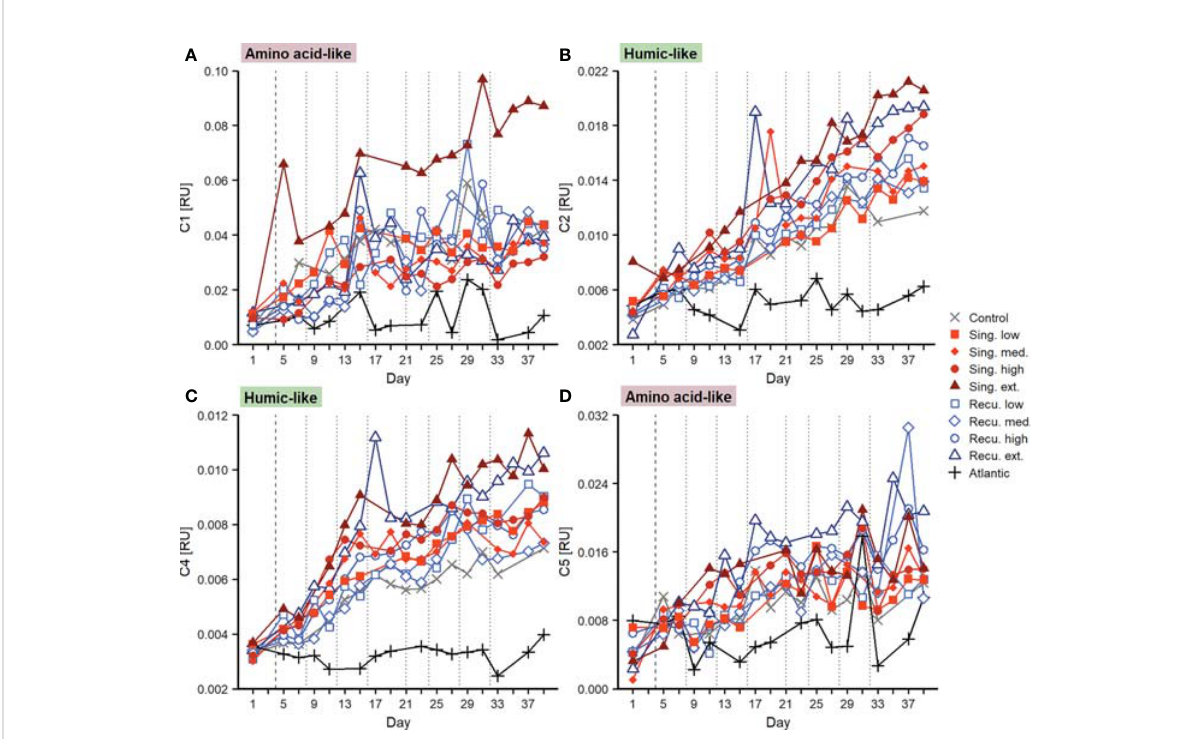
FIGURE 6 Changes in fl uorescent dissolved organic matter during the experiment. Temporal evolution of PARAFAC components (A) C1, (B) C2, (C) C4 and (D) C5. Vertical lines indicate deep water additions of singular (dashed) and recurring (dashed and dotted)